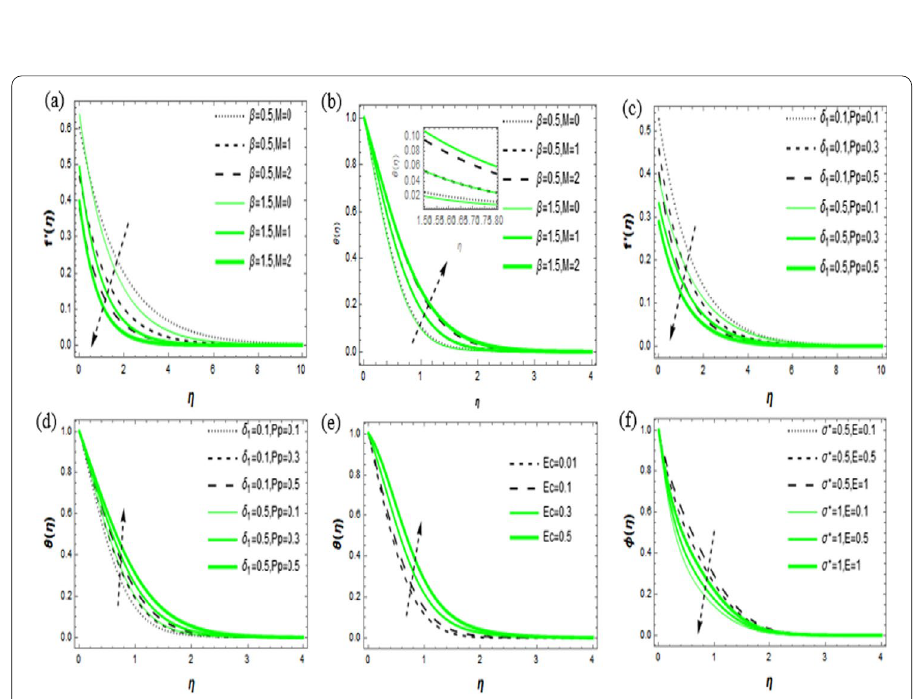
Fig. 6 a , b , c , d , e , and f Effect of Casson parameter, magnetic field parameter, porosity and first-order slip parameters, second-order slip, wall transpiration (suction/injection) Eckert number, chemical reaction and activation energy parameters on velocity, fluid temperature, amd concentration